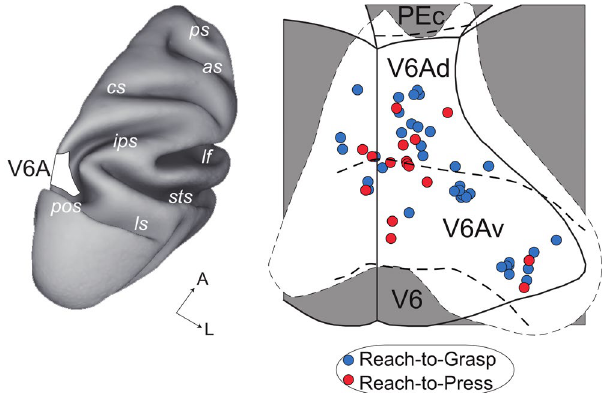
Figure 7. Absence of functional clustering in V6A neurons. Left, the location of area V6A in the parieto- occipital sulcus (pos) is shown in a dorso-lateral view of a hemisphere reconstructed in 3D using the Caret software (https://www.nitrc.org/projects/caret/). ls, lunate sulcus; sts, superior temporal sulcus; ips, intraparietal sulcus; cs, central sulcus; as, arcuate sulcus; ps, principal sulcus; a, anterior; l, lateral. Right, topographical representation of area V6A, with precise representation of the recording sites (location on the map) and functional properties (color coding) of the neurons (circles on the map) with reliable task-related modulations of activity during the DELAY epoch (note that Task cells and Task/Background cells are represented together, considering for both only task-related modulations). Blue and red colors indicate a preference for the Reach- to-Grasp and Reach-to-Press, respectively. Dorsal and ventral sectors of V6A (V6Ad, V6Av) are shown in the map (note that maps of each left hemisphere were flipped, so that all recording sites were projected on the maps of the right hemispheres); V6, area V6 6 ; PEc, area PEc 92 . No evidence for functional clustering is present in the recorded